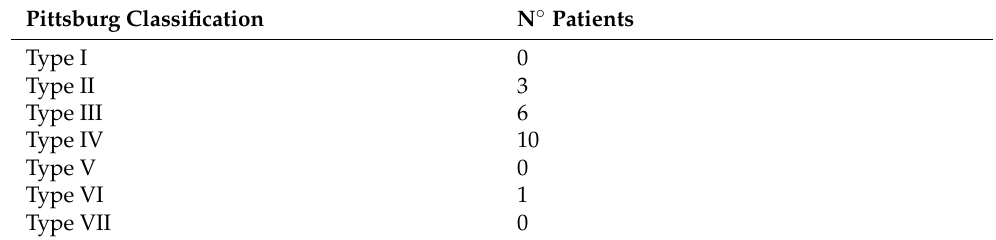
Table 3. Pittsburgh classification.